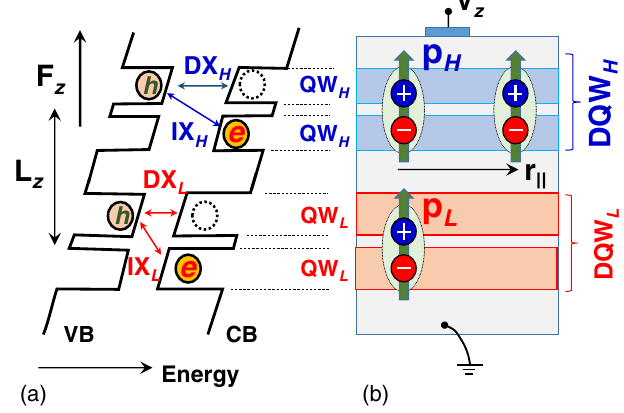
FIG. 1. Interactions between indirect (or dipolar) excitons (IX i ’ s, i ¼ L , H ) in a sample with coupled double quantum wells (DQW i ’ s). (a) Energy diagram and (b) layer structure of the (Al,Ga)As sample. Each DQW consists of two GaAs QWs separated by thin tunneling barriers. A 10-nm-thick (Al,Ga)As barrier between the DQWs prevents carrier tunneling between them. The transverse electric field F z bends the conduction (CB) and valence bands (VB). Under laser excitation, the spatial separation between electrons ( e ) and holes ( h ) in each DQW creates IX i ’ s with an electric dipole moment p i and reduced energy with respect to intrawell direct excitons (DX i ’ s). The corresponding centers of the DQWs are spaced by L z , and the QW pairs in the DQWs have different widths to enable the selective optical excitation of their DX